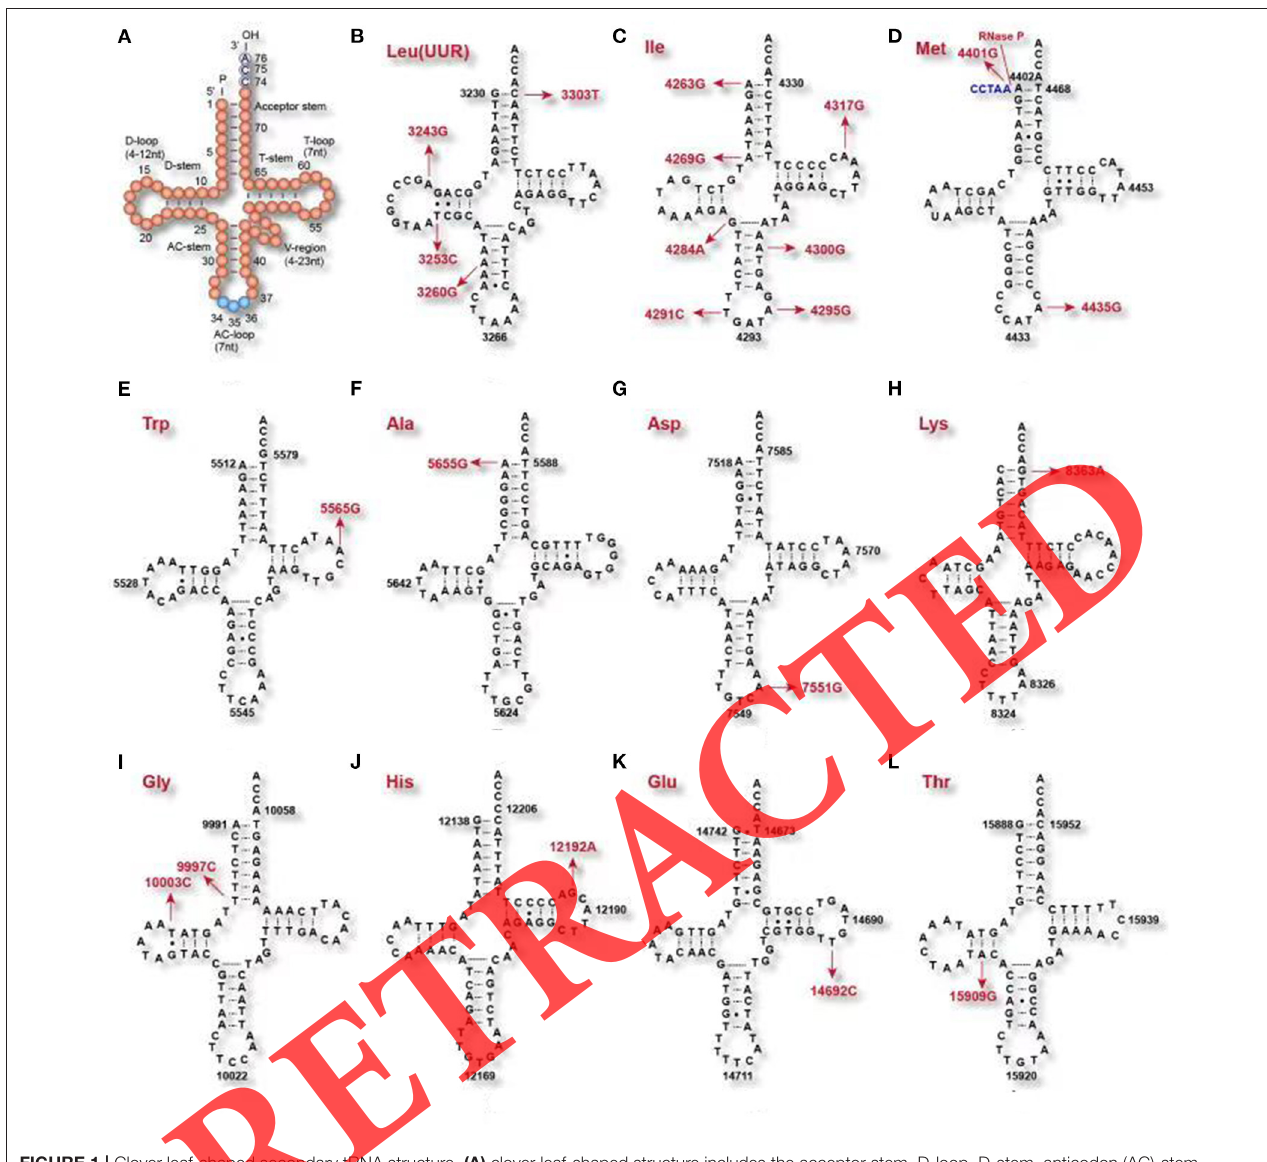
FIGURE 1 | Clover leaf-shaped secondary tRNA structure. (A) clover leaf-shaped structure includes the acceptor stem, D-loop, D-stem, anticodon (AC)-stem, AC-loop, T-loop, T-stem and variable (V) region. (B–L) tRNAs mutations associated with cardiac disease and EH.